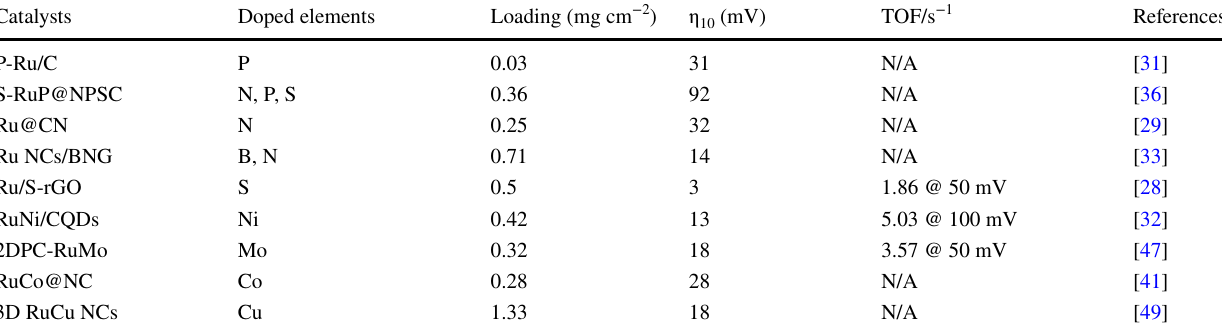
Table 2 HER performance doped with different elements at 1.0 M KOH Catalysts Doped